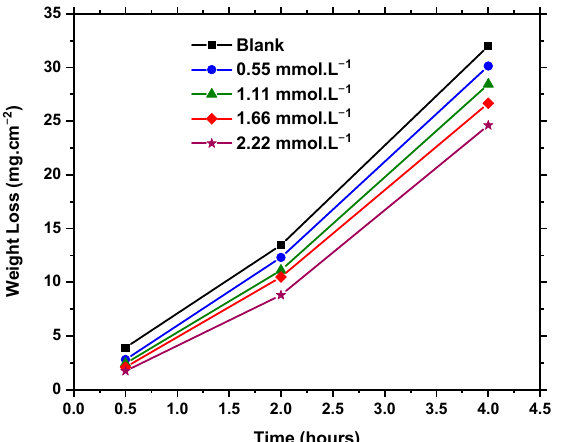
Figure 2. Weight loss of C-steel specimens immersed in 5 M HCl solution in the presence and absence of 0.55, 1.11, 1.66, and 2.22 mmol·L −1 Q-22 inhibitor at 25 °C.